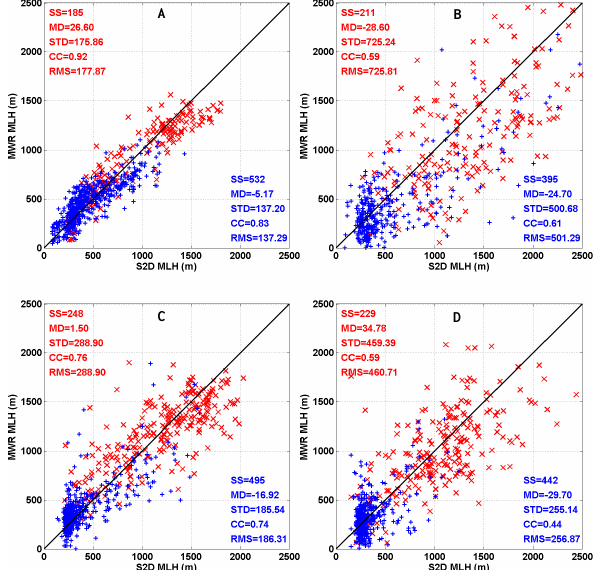
Figure 5: Scatter plots of 1-hour average MLH (m AGL) estimated from MWR (Y axis) and 3 Fig. 5. Scatter plots of 1-hour average MLH (ma.g.l.) estimated lidar (X axis) observations during day (red) and night (blue). Each panel reports the sample 4 from MWR ( y axis) and lidar ( x axis) observations during day size (SS), the mean difference (MD), the standard deviation (STD), the root-mean-square 5 (red) and night (blue). Each panel reports the sample size (SS), the (RMS), and the correlation coefficient (CC). The diagonal 1:1 bisector line is also shown 6 mean difference (MD), the standard deviation (STD), the root mean (black bold). The four panels indicate March (A), July (B), August (C), and September (D) 7 square (RMS), and the correlation coefficient (CC). The diagonal 2011. 8 1 : 1 bisector line is also shown (black bold). The four panels indi- cate March (A) , July (B) , August (C) , and September (D) 2011.